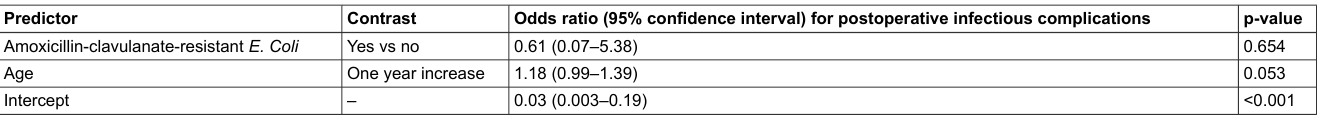
Table 4: Multivariable analysis. Predictor Contrast Odds ratio (95% confidence interval) for postoperative infectious complications Amoxicillin-clavulanate-resistant E.